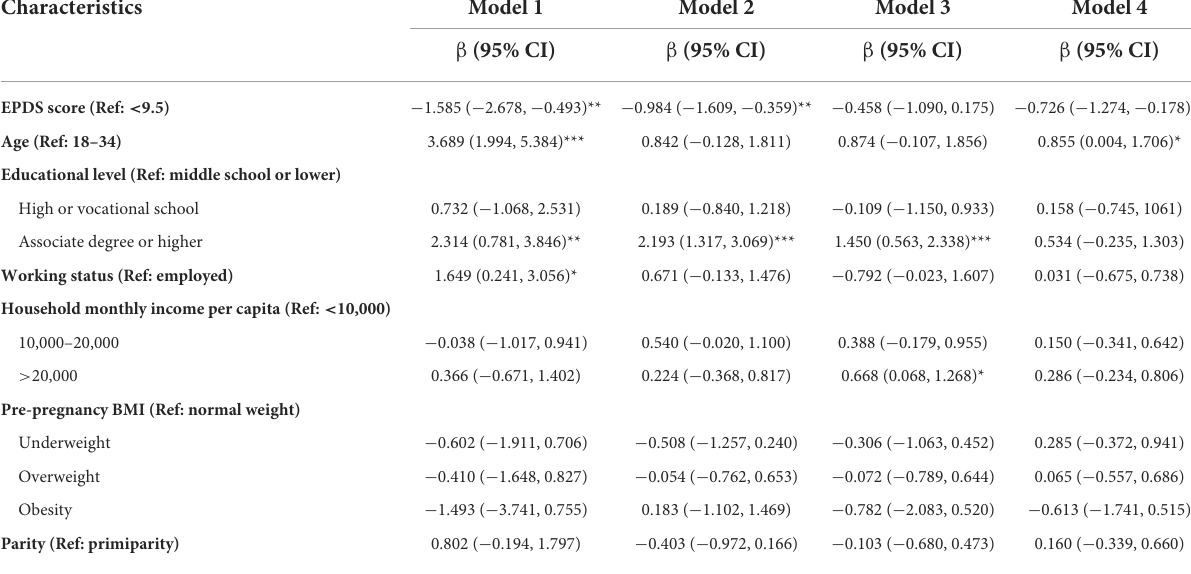
TABLE 4 Multivariable linear regression analysis for EPDS and WMS scores.